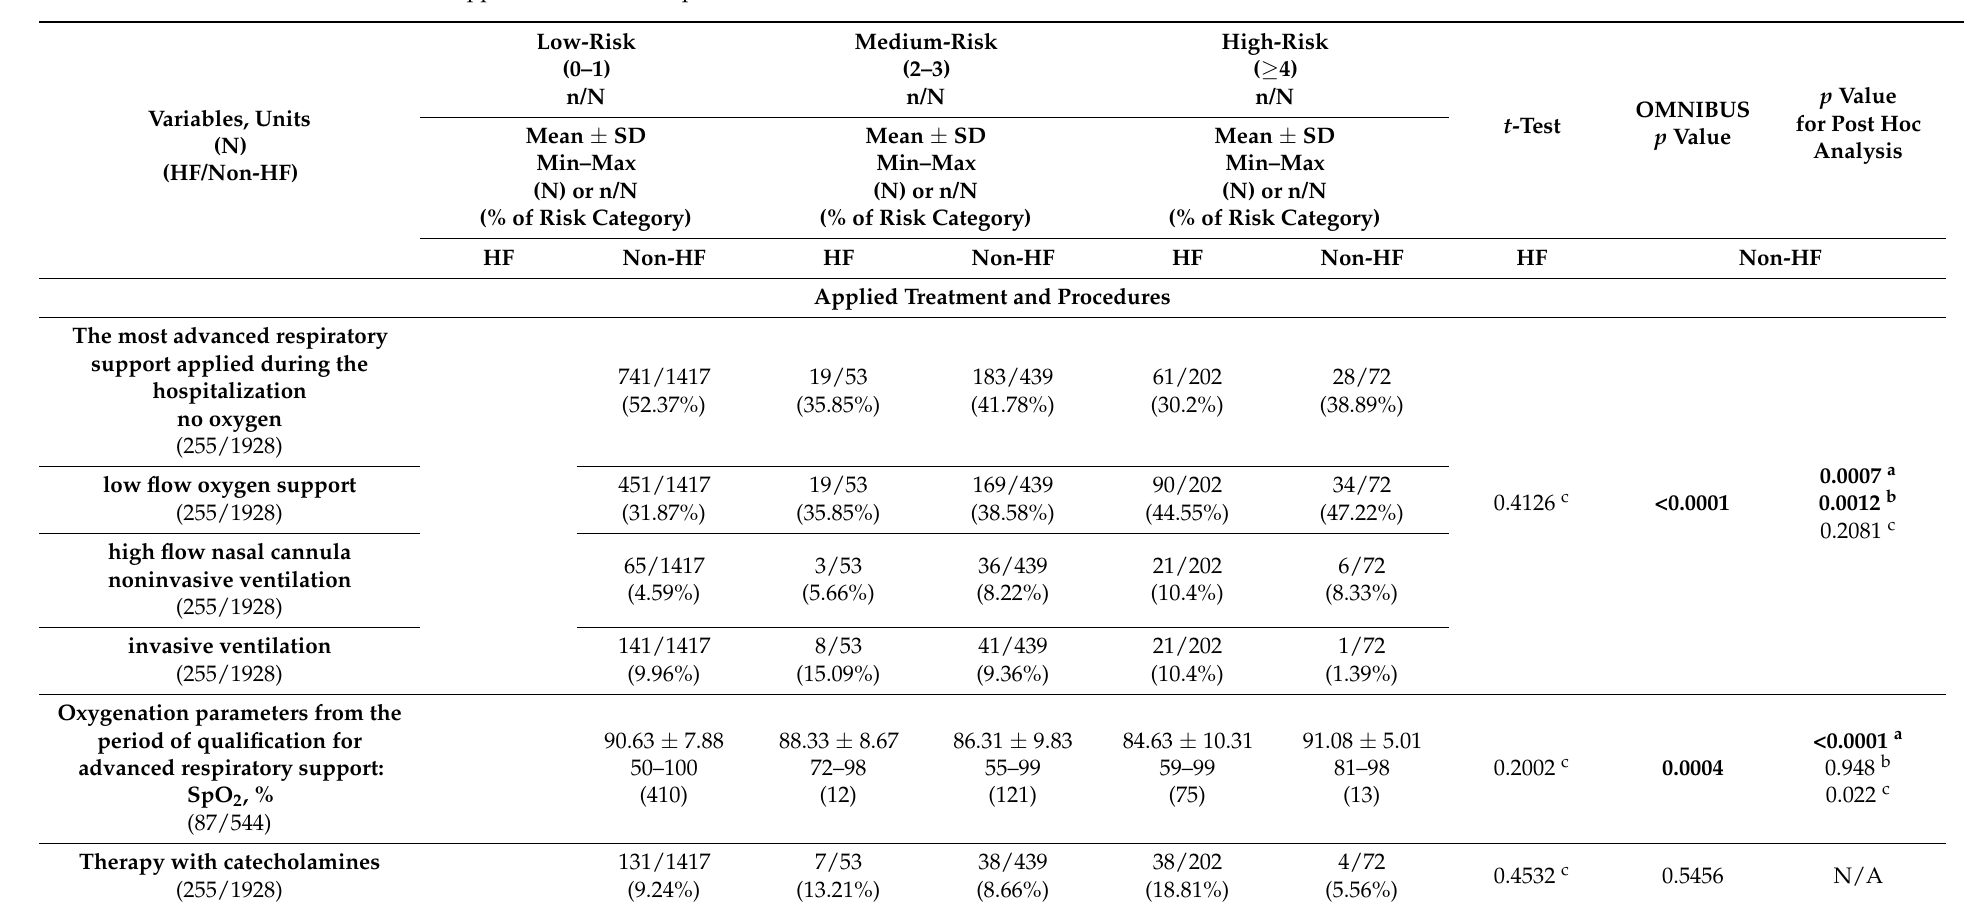
Table 3. Applied treatment and